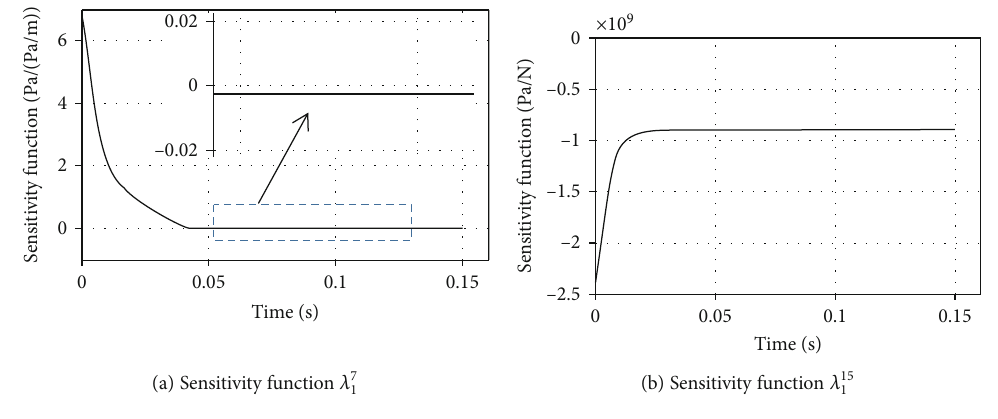
Figure 6: Curves of sensitivity